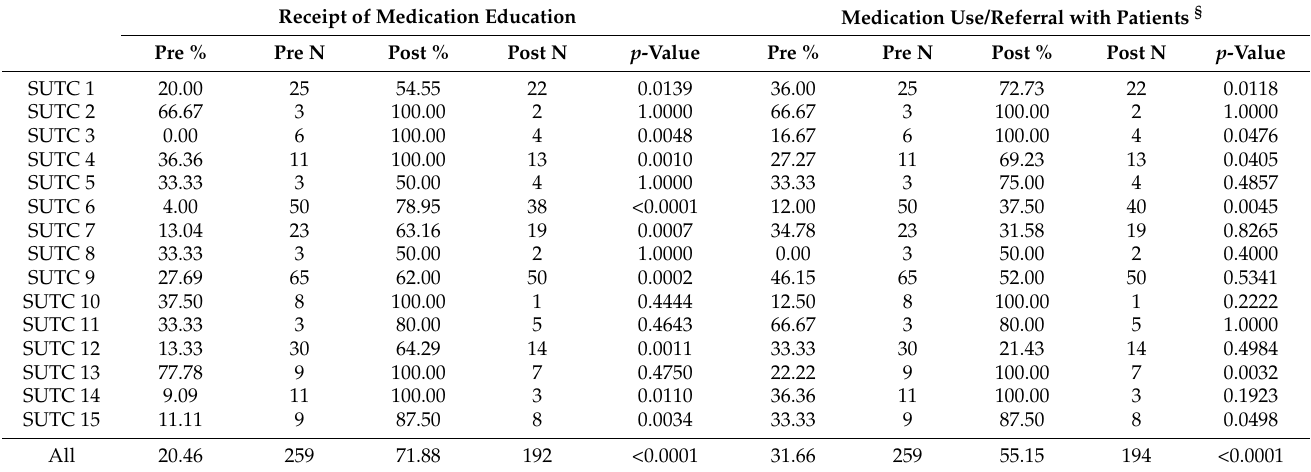
Table 3. Changes in provider-reported past-year education receipt on the use of or referral for pharmacotherapies for tobacco use and the regular use of recommendation/referral for medication with patients who use tobacco from pre- to post-implementation of a comprehensive tobacco-free workplace program that provided education on medication use/referral in 15 substance use treatment centers in Texas (pre-implementation n = 259 providers; post-implementation n = 194 providers). Receipt of Medication Education